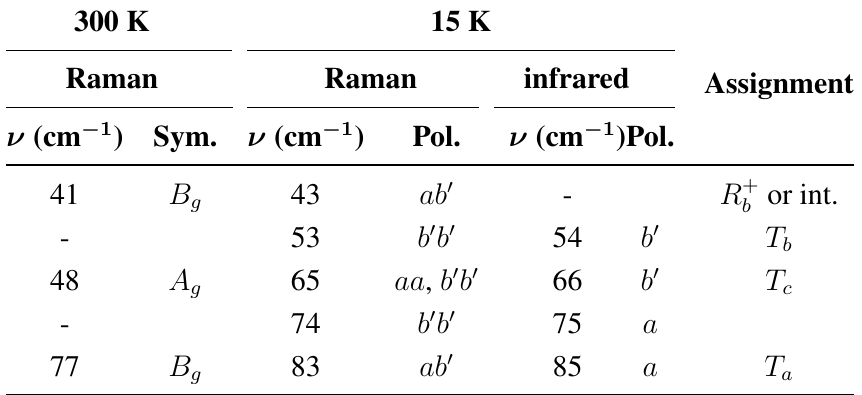
AsF lattice modes 2 6